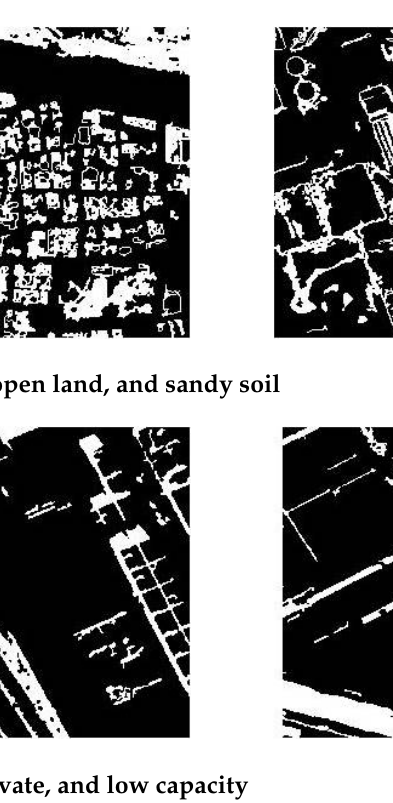
Figure 6. Samples of